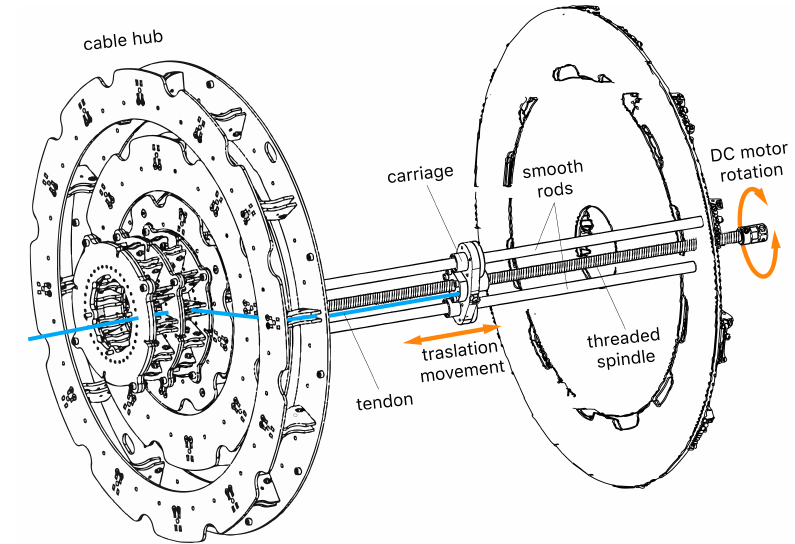
Figure 4. Drawing of the actuation system for just one tendon. The DC motor is connected to a threaded spindle that converts the rotation to a linear movement of a carriage, in which a tendon is anchored and then guided through a set of pulleys to the